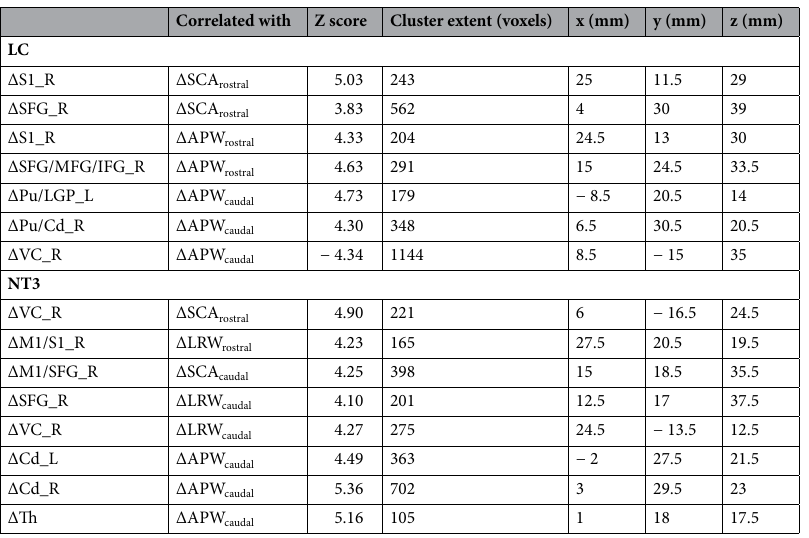
Table 3. Correlation between structural alterations in the brain and spinal cord. LC lesion control, NT3 neurotrophin-3, L left, R right, SCA spinal cord area, LRW left–right width, APW anterior–posterior width, S1 primary somatosensory cortex, SFG superior frontal gyrus, MFG middle frontal gyrus, IFG inferior frontal gyrus, Pu putamen, LGP lateral globus pallidus, Cd caudate nucleus, VC visual cortex, M1 primary motor cortex, Th thalamus.